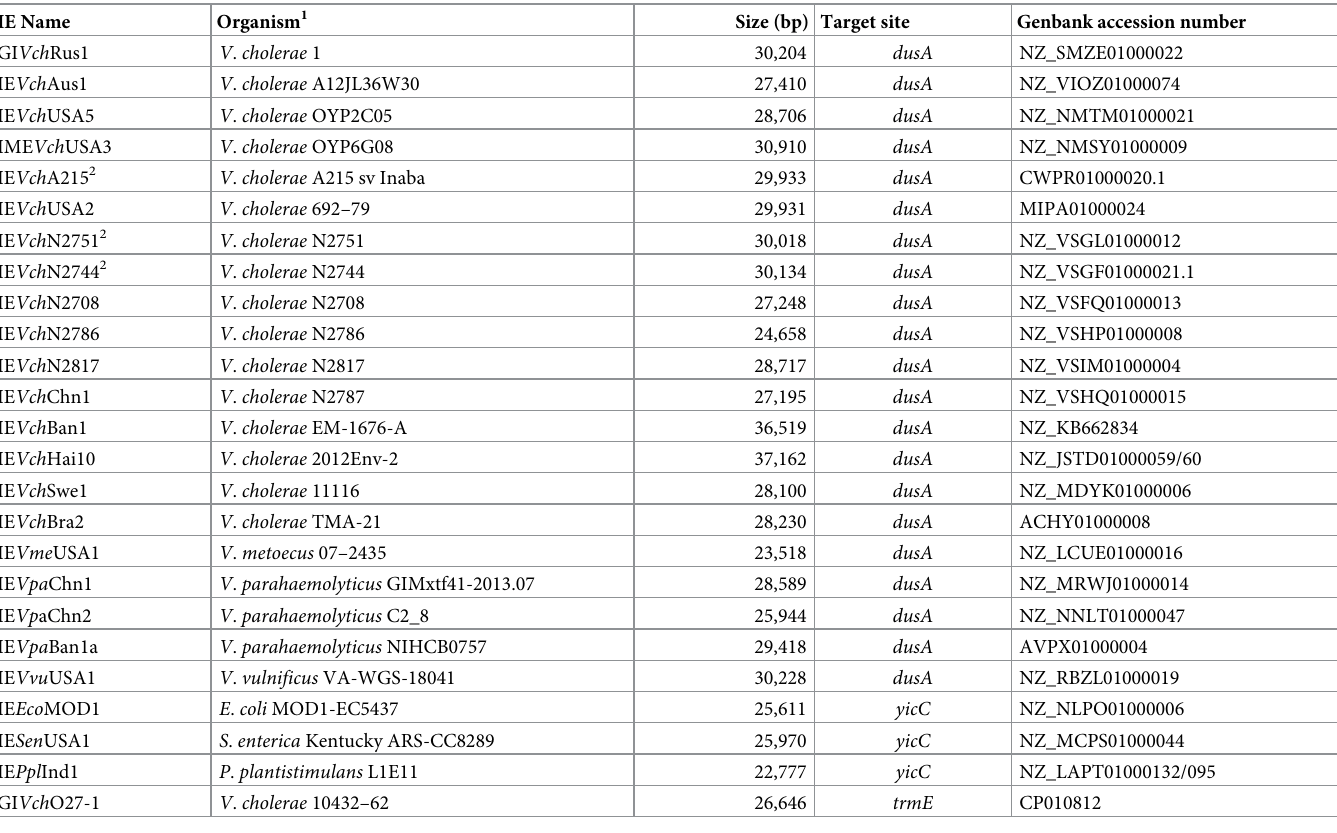
Table 1. Main features of the IEs described in this study.